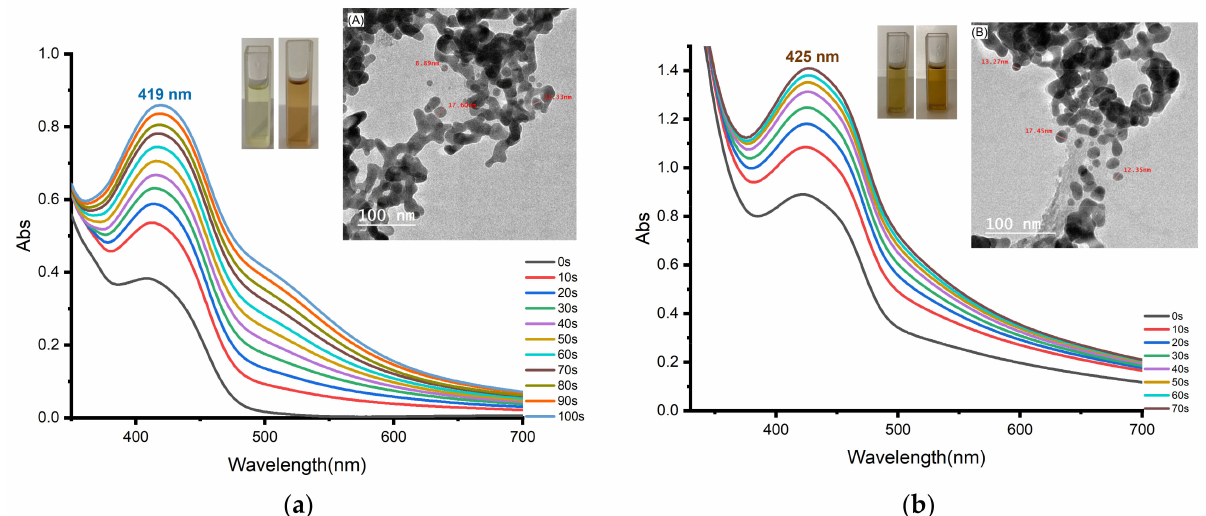
Figure 5. Evolution of the absorption spectra of the irradiated mixtures ( λ irr = 405 nm). Solution (R3 ( a ) and R4 ( b )) 1 × 10 − 4 M AgNO 3 2 wt% dissolved in 25 mL of DMF. TEM micrographs of silver